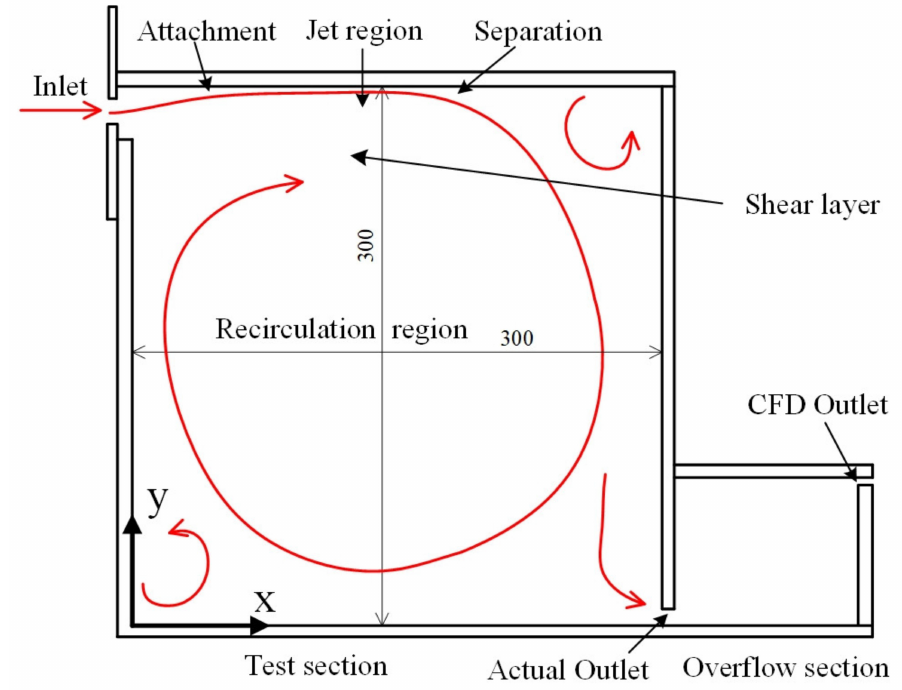
Figure 1. The reduced-scale experimental configuration of Van Hooff et al.